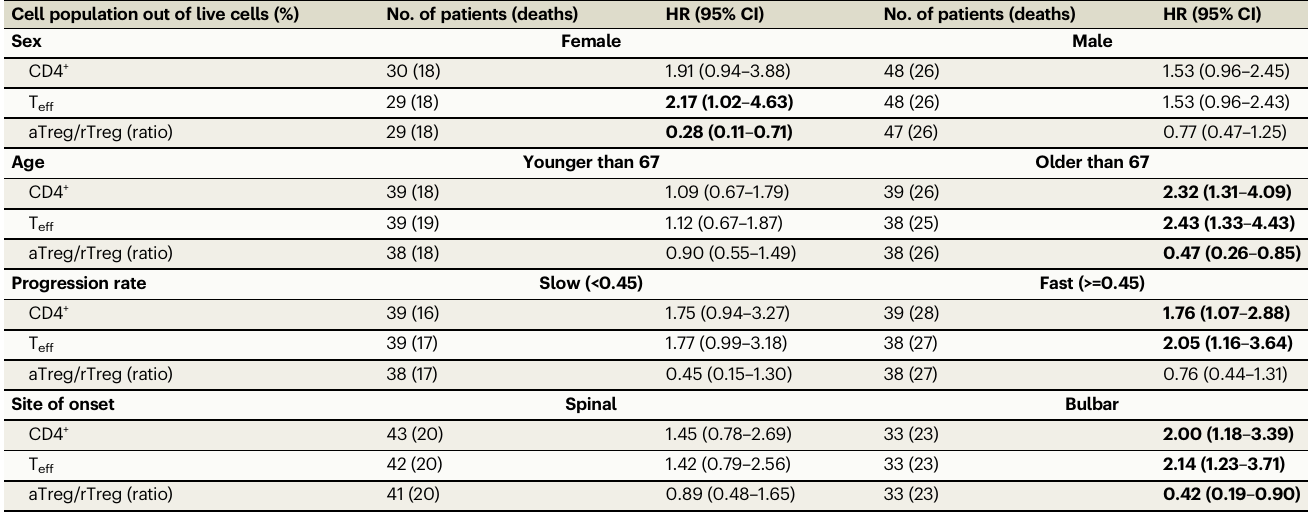
Table 2 | Hazard ratios (HR) and their 95% con fi dence intervals (CI) of death in relation to per standard deviation increase in the frequency of T cell subsets in blood or cerebrospinal fl uid, adjusted for age at diagnosis, sex, site of onset, delay in diagnosis, disease progression rate at diagnosis, body mass index (BMI), and the timedifference between measurement of BMI and blood sampling, strati fi ed analysis by sex, age, progression rate, and site of onset Cell population out of live cells